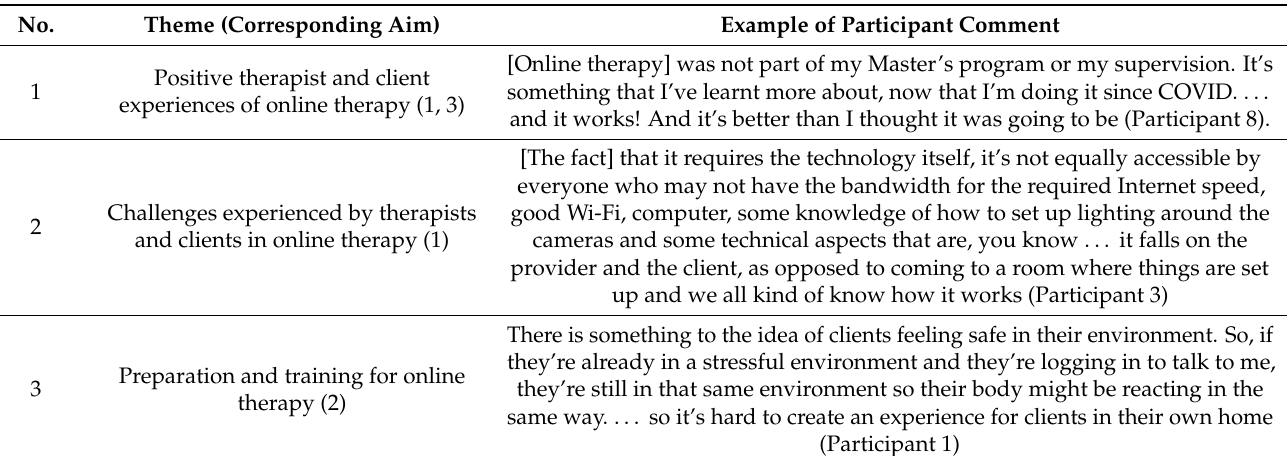
Table 2. Themes, corresponding aims, and example